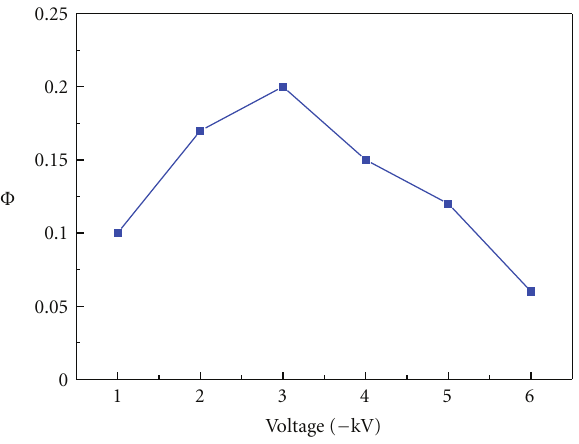
Voltage ( − kV) ) of SP/ -CDP complex at 150 Φ 𝛾𝛾